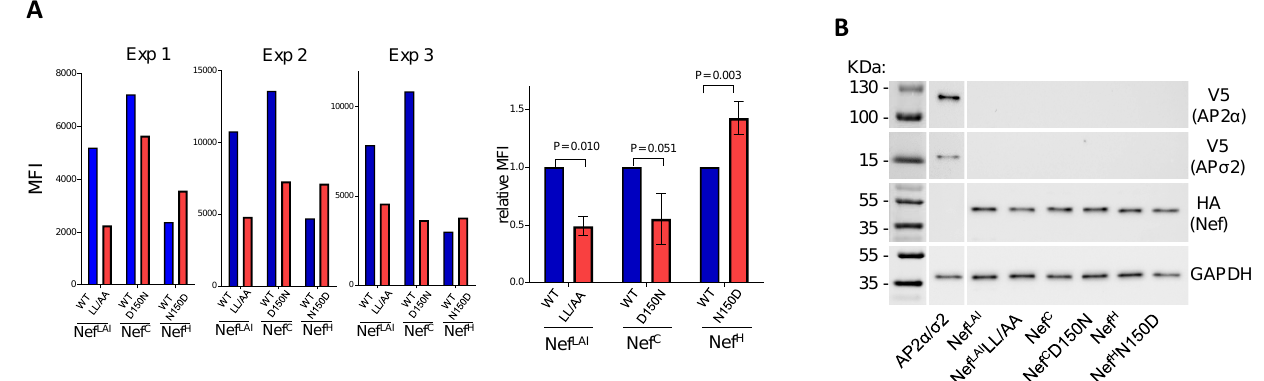
Figure 6. An Asp at Nef residue 150 associates with the higher recruitment of AP2. ( A ): Mean fluorescence intensity (MFI) of BiFC signal from three independent experiments in cells expressing the indicated Nef proteins tagged with Venus N-HA and AP2 α / σ 2 hemicomplex tagged with V5-Venus C-terminal fragment. Mutation D150N reduced complementation fluorescence from Nef C : AP2 α / σ 2, while substitution N150D in Nef H increased the signal associated with AP2 α / σ 2 hemicomplex. As a control, the abrogation of AP2 binding motif in Nef LAI (LL/AA) also reduced the association with the AP2 α / σ 2 hemicomplex, which produced no signal when expressed alone. MFI was measured in three independent experiments ( left ), and presented as average fold BiFC signal over control (WT) Nef ( right ). Mean ± s.d. Shown is the P-value derived from one-sample t -test (GraphPad) ( B ). A western blot analysis of AP2 α / σ 2-VN-V5 and Nef-HA-VC shows no difference in cellular expression between